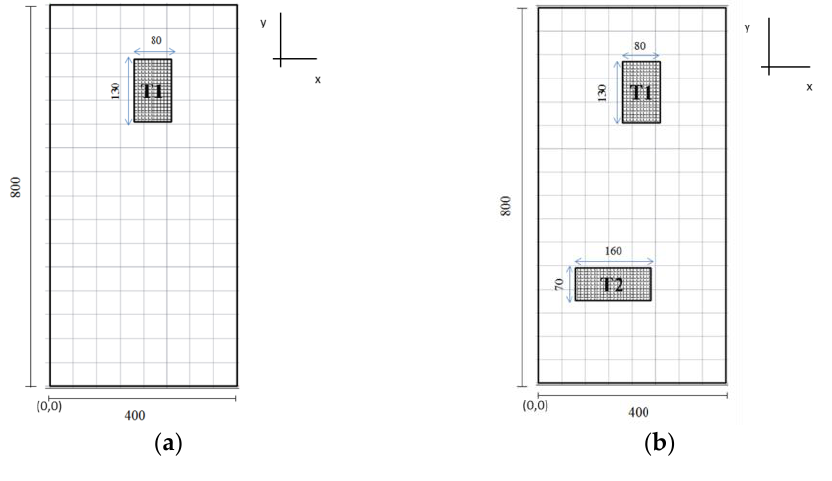
Figure 4. Plan view of construction project. ( a ) Stage 1: Construction of Terminal 1; ( b ) Stage 2: Construction of Terminal 2.